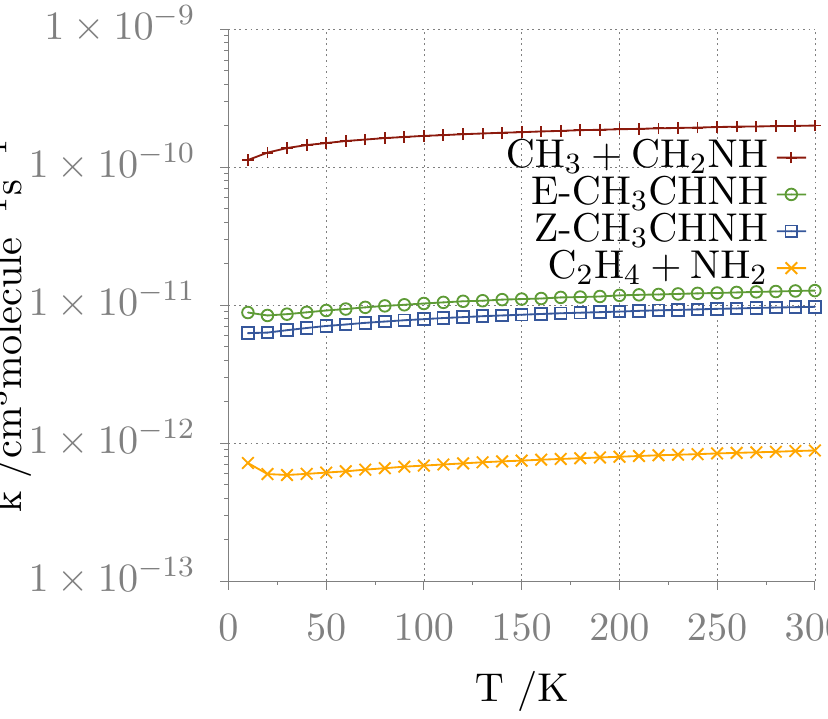
Figure 4. Rate coefficients as a function of temperature for the four